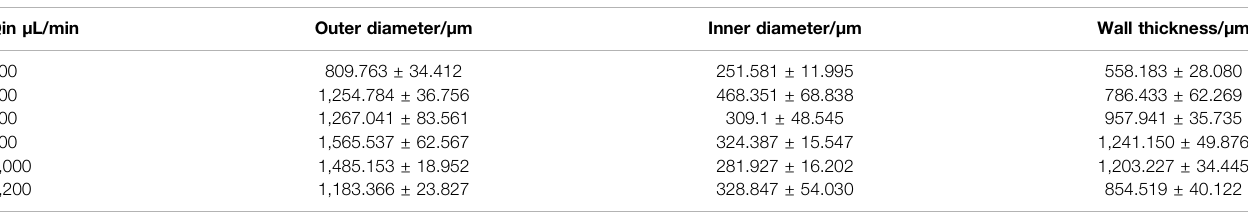
TABLE 1 | Average value of microtubule structure under different inner liquid fl ow rates.